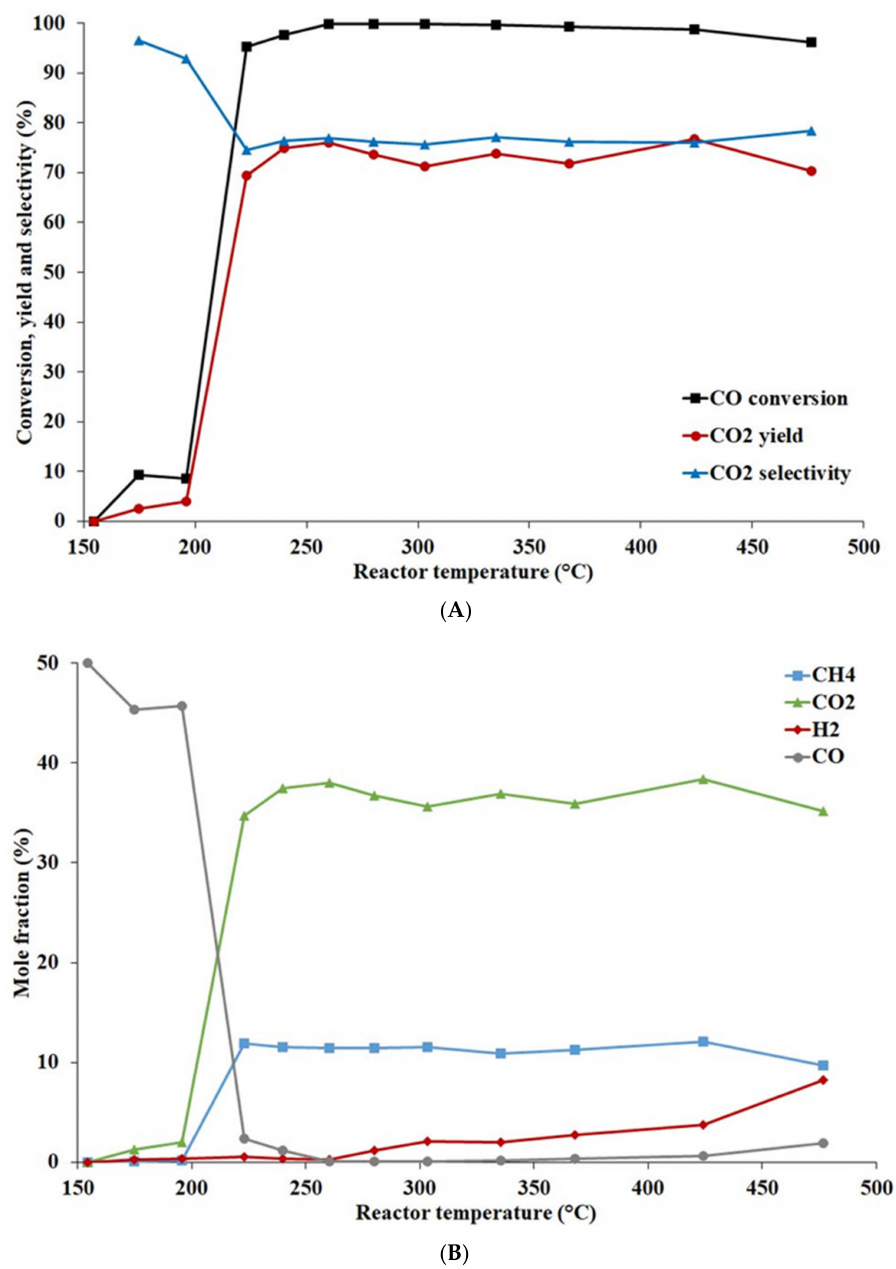
Figure 3. Catalytic tests with feed gas mixture 1 (50 mole% CO and 50 mole% N 2 ) at pressure 2 MPa over a commercial Ni-based catalyst: ( A )—CO conversion, CO 2 yield, and CO 2 selectivity; ( B )—composition of produced